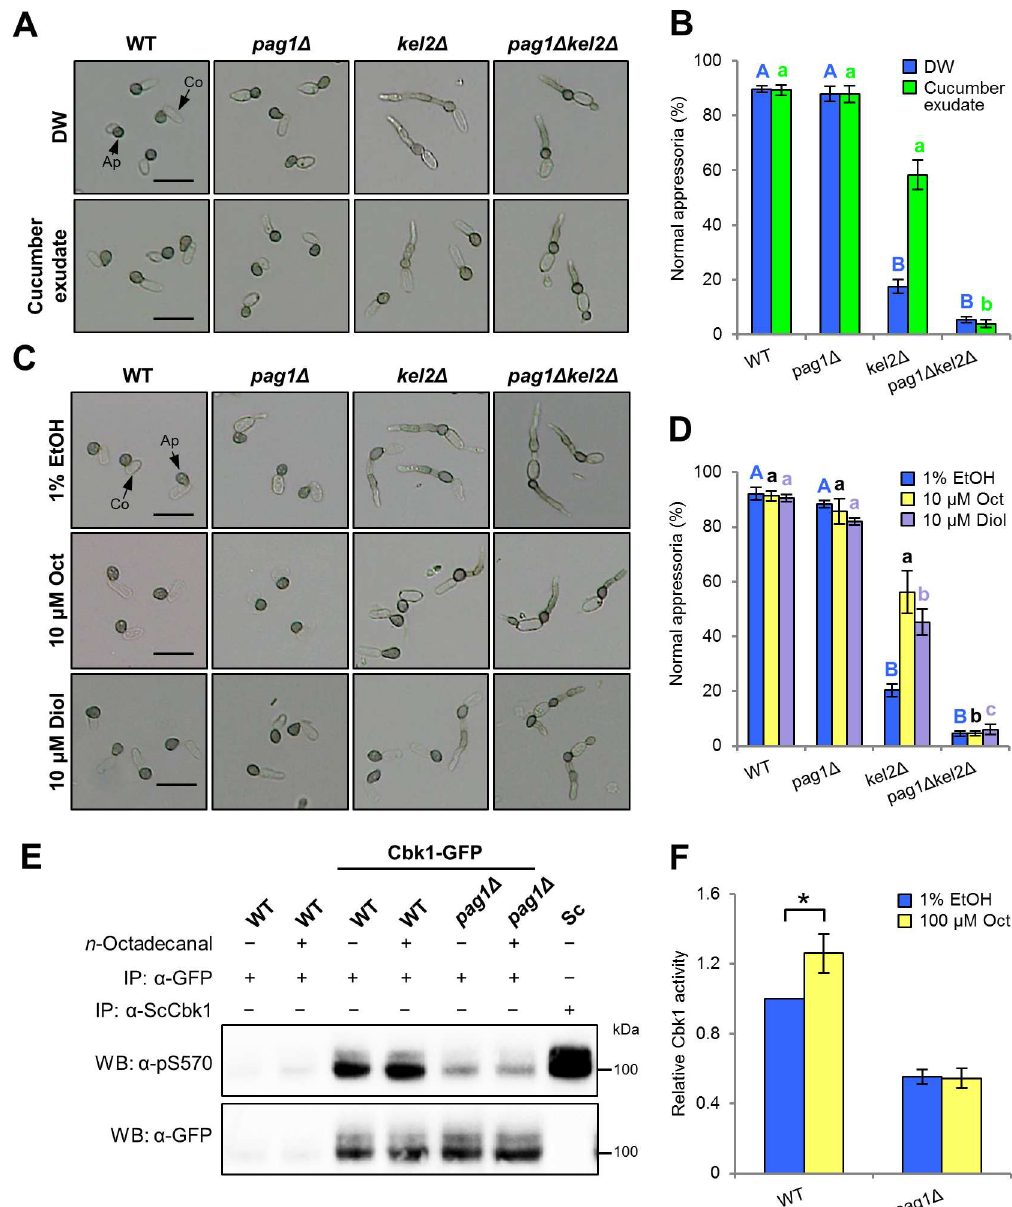
Fig 4. Cutin monomers from cucumber exudate function as a signal for inducing appressorium development of C . orbiculare via the MOR components. (A) Appressorium development in the presenceof exudatefrom cucumbercotyledons.Conidialsuspensions of indicatedstrains were preparedwith distilledwater or cucumber exudateandincubatedon a petri dish at 24˚C for 24 h. Co, conidium; Ap, appressorium. Scale bar, 20 μ m. (B) Mean percentage ( ± SE)of normalappressorium formation in the presenceof exudatefrom detachedcucumber cotyledons. At least 300 appressoria on a polystyrenepetri dish wereobservedat each experiment, and three independent experiments were performed. Values are meansof three replications. Bars with differentletters indicatesignificantly differences(Tukey’s test; P < 0.01). (C) Appressorium development in the presenceof cutin monomers. Conidial suspensionsof indicatedstrains werepreparedin 1% ethanol(EtOH), 10 μ M n -octadecanal (Oct) or 10 μ M 1, 16-hexadecanediol(Diol) and incubatedon a polystyrene petri dish at 24˚C for 24 h. Scale bar, 20 μ m. (D) Mean percentage ( ± SE)of normalappressorium formation in the presenceof cutin monomers. At least 300appressoria on a petri dish wereobservedin eachof three independentexperiments. Values are meansof three replications. Bars with different letters indicatesignificantdifferences(Tukey’s test; P < 0.01). (E) CoCbk1phosphorylationof CoCbk1-GFP purifiedfrom myceliaof the indicatedstrains, incubatedin the presenceof n -octadecanal. 4-day-oldSD cultures were treated with 100 μ M n -octadecanal (Oct) or 1% ethanol(EtOH) at 24˚C for 24 h. The proteinswere